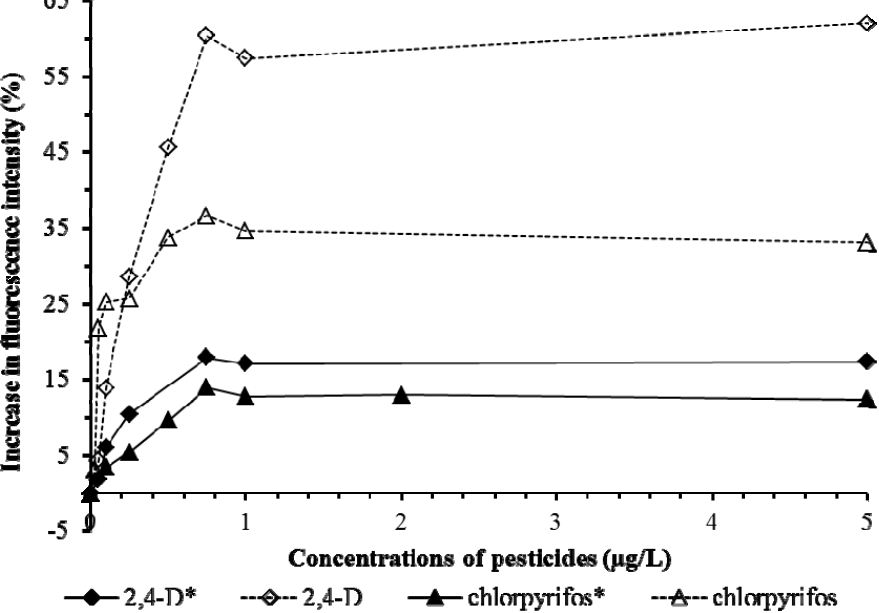
Figure 7. Biosensors tests on pesticides 2,4-D and chlorpyrifos. The asterisk * marks the results from the tests with pHEMA.